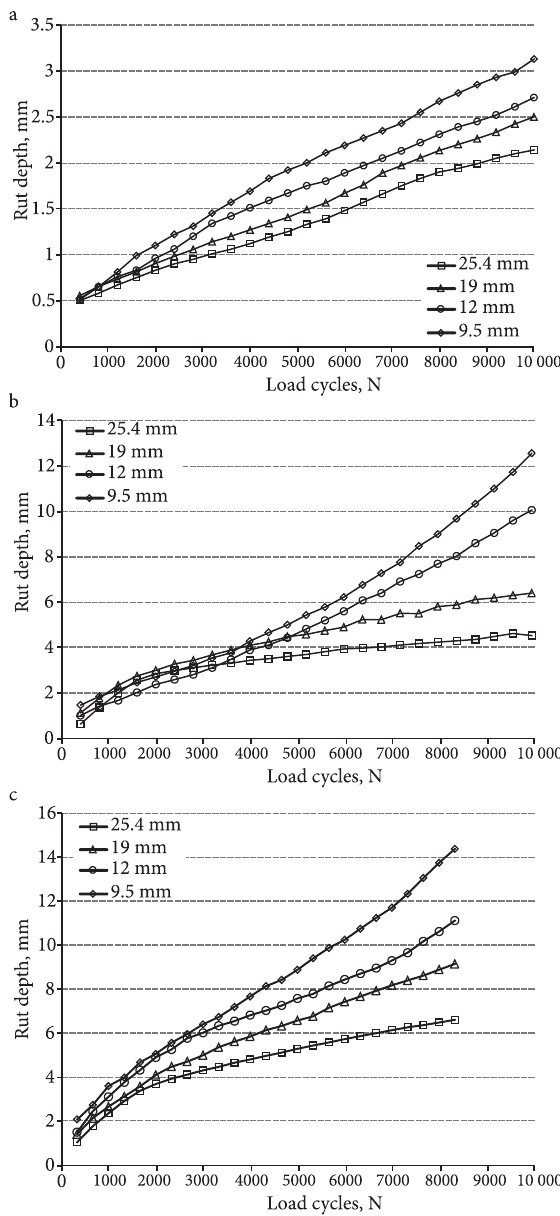
Fig. 3. Rut depth formation of SMA at: a – 25 °C; b – 40 °C; c – 60 °C Table 2. Rut depth in SMA mixtures tested under the wheel tracking machine Rut depth of SMA NMAS size, mm